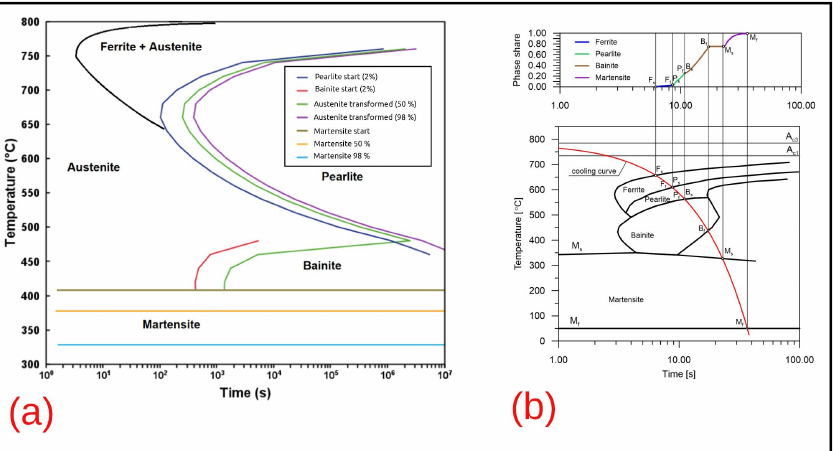
Figure 1. Typical Transformation diagrams for alloys are illustrated. Time temperature transforma- tion (TTT) diagram [3] for 5Cr-0.5Mo-0.1C steel is presented in ( a ). The image ( b ) represents the Continuous Cooling Transformation (CCT) diagrams for Medium Carbon Steel [4]. The time scale in TTT diagram is longer than that of CCT diagram. Such diagrams offer a possibility to obtain input information for machine learning models.